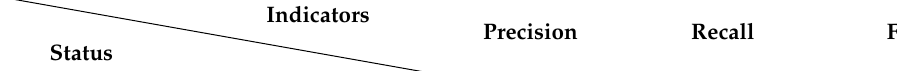
Table 5. Performance comparison of the two network models on the test dataset.